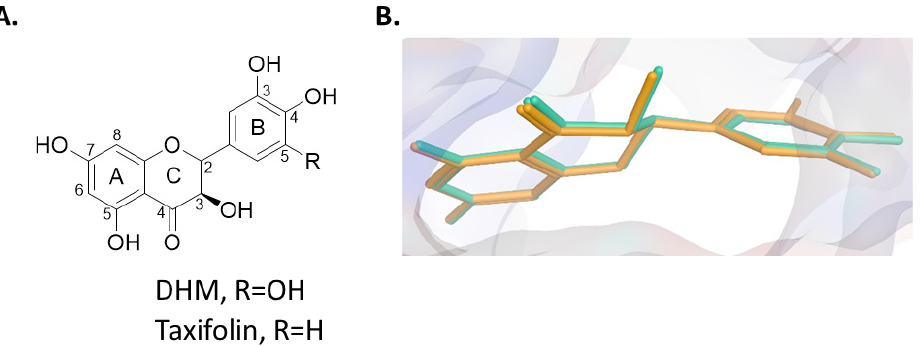
Figure 5. ( A ) Chemical structures of taxifolin (a potent Pgp ATPase inhibitor) and DHM, depicting variation only at the 5 ′ position of ring B. ( B ) Overlay of lowest binding energy conformations of taxifolin (green) and DHM (yellow) in NBD1 of human Pgp (PDB: 6C0V), depicting near-perfect overlap.